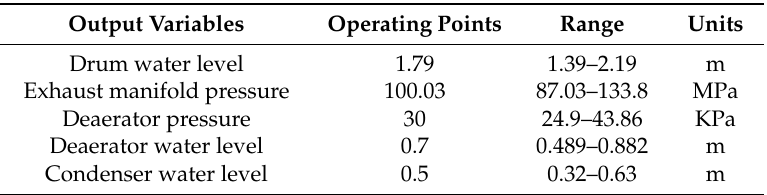
Table 1. Parameters used in steam/water